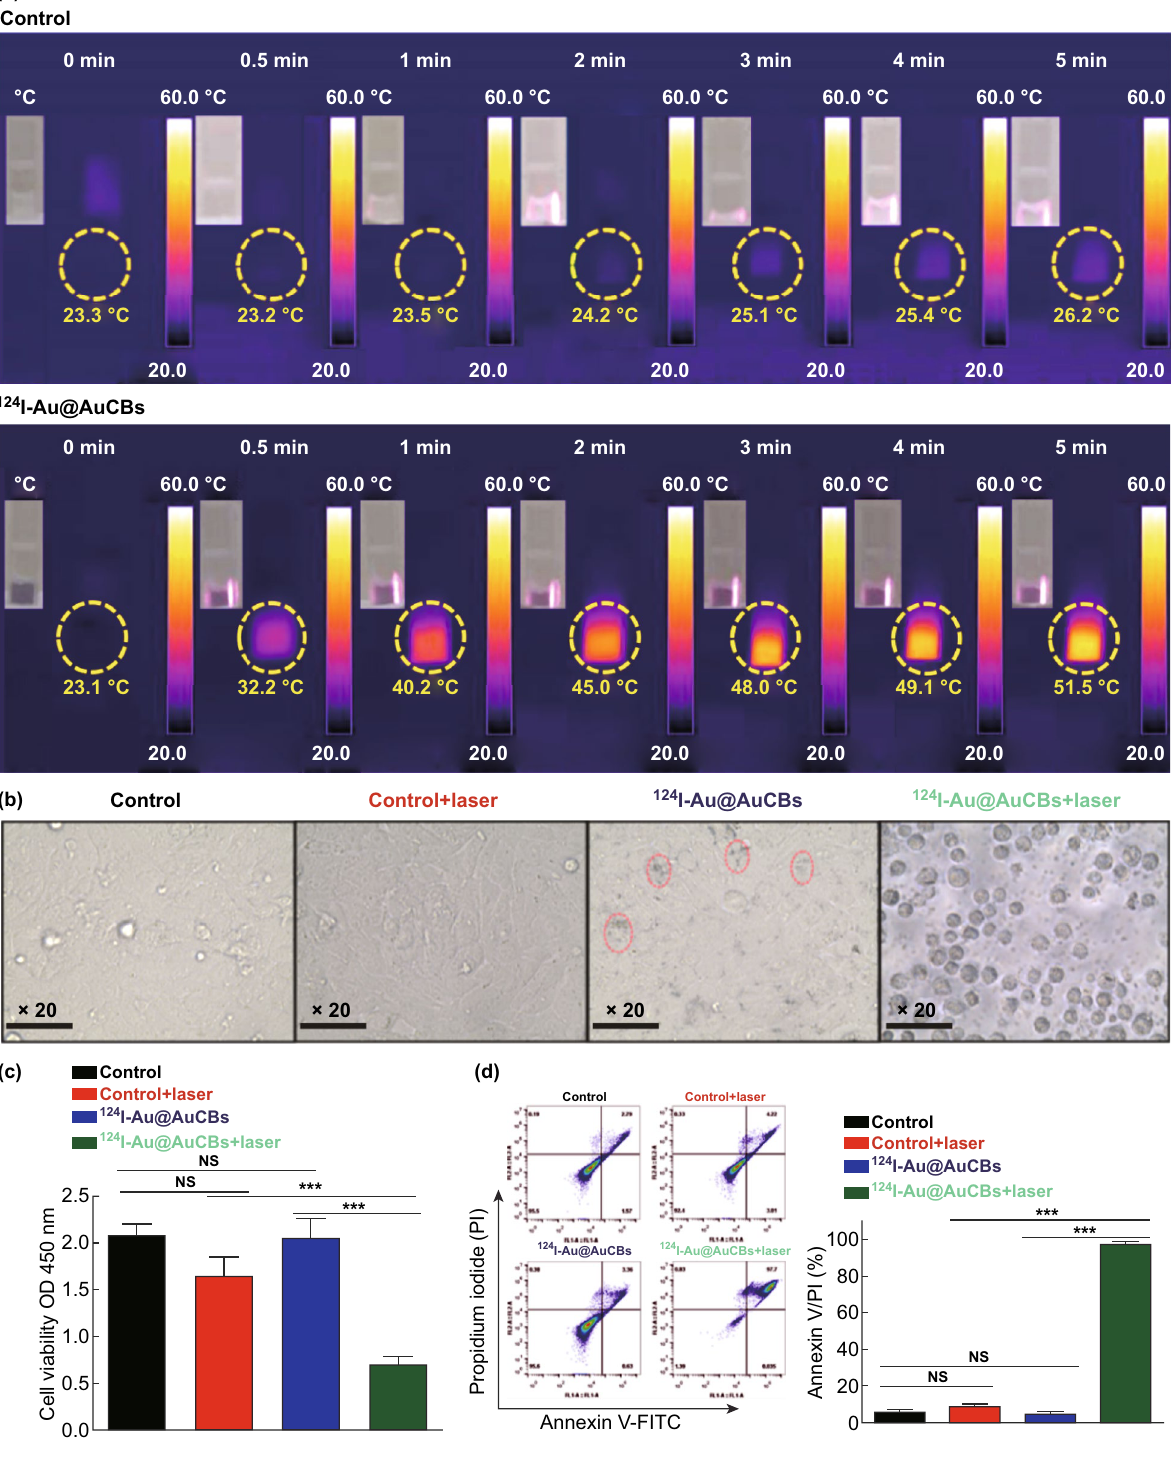
Fig. 3 Cytotoxic effects of 124 I‑Au@AuCBs in colon cancer CT26 cells after photothermal therapy. a NIR images of 124 I‑Au@AuCB‑labeled CT26 cells after irradiation with an NIR laser (6 W cm −2 , 5 min). b Microscopic images of 124 I‑Au@AuCB‑labeled or 124 I‑Au@AuCB‑labeled CT26 cells irradiated with an NIR laser. c Analysis of cell viability and d apoptosis in irradiated cells via annexin V/PI staining. ***P < 0.0001; NS not